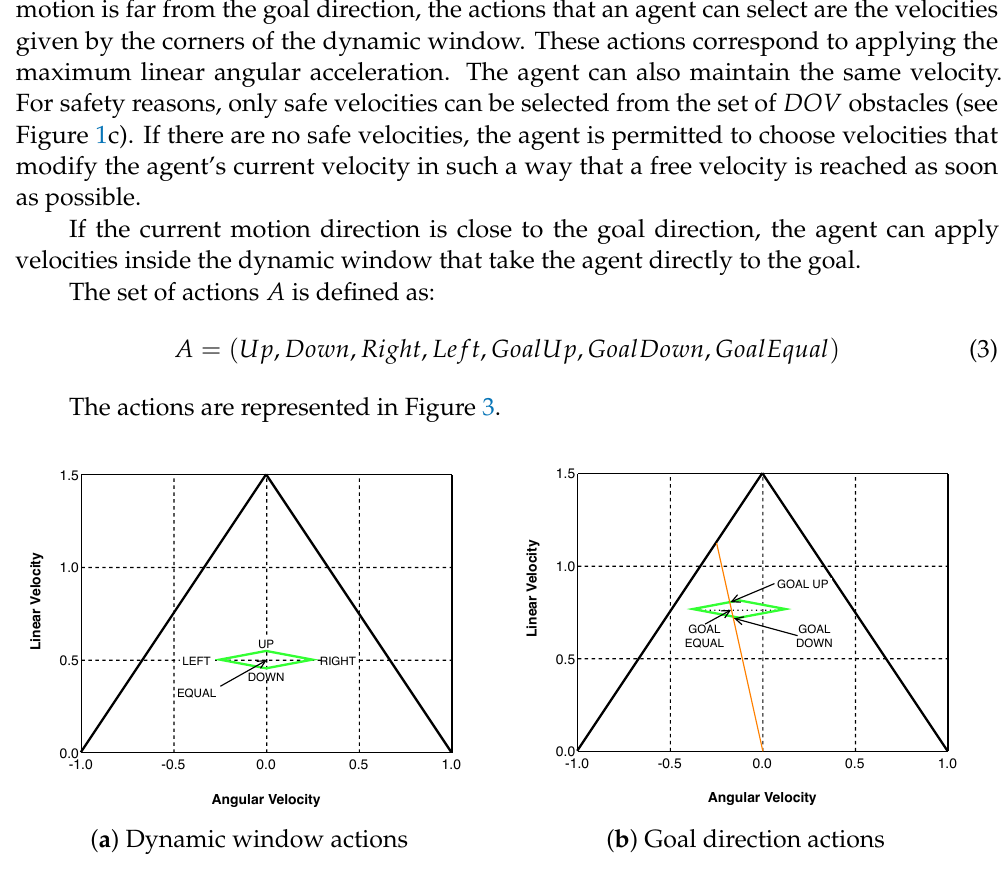
Figure 3. Actions: ( a ) the robot orientation is far from the goal direction; ( b ) the robot is near to being aligned with the